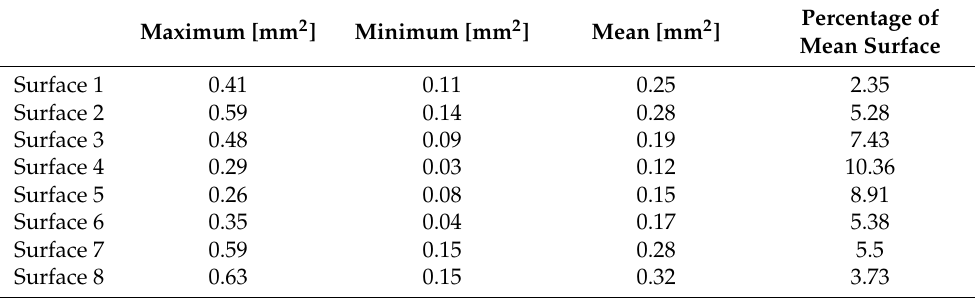
Table 2. Standard deviation of repeated measures for each surface over 18 prepared